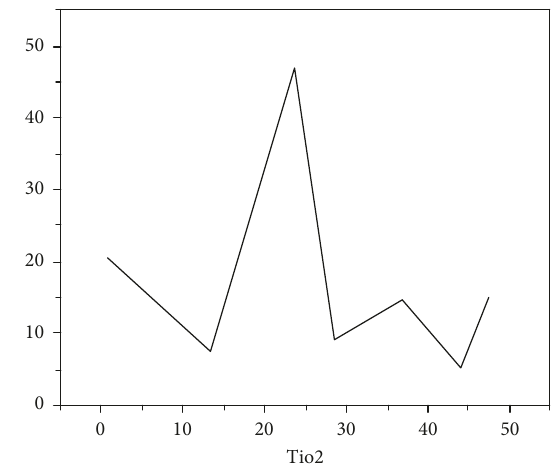
Figure 2: X-ray diffraction pattern of the nano-TiO